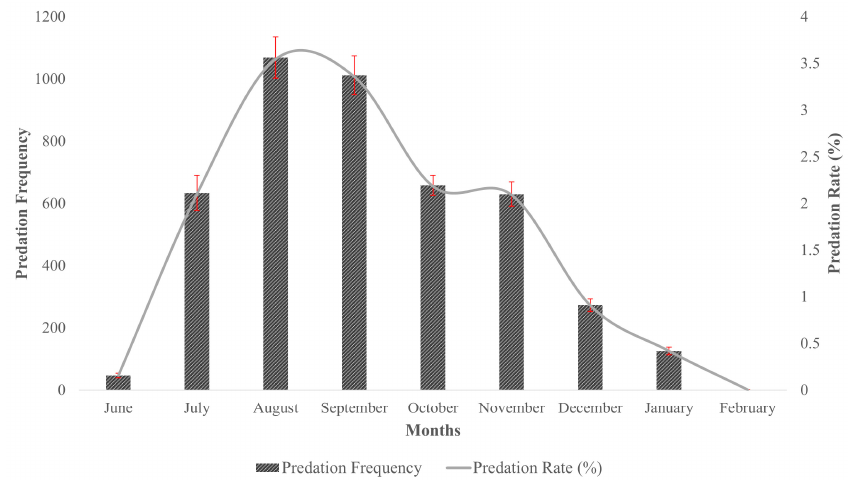
Figure 3. Monthly predation rates (%) in Corozalito during the sampling period (2008–2021).